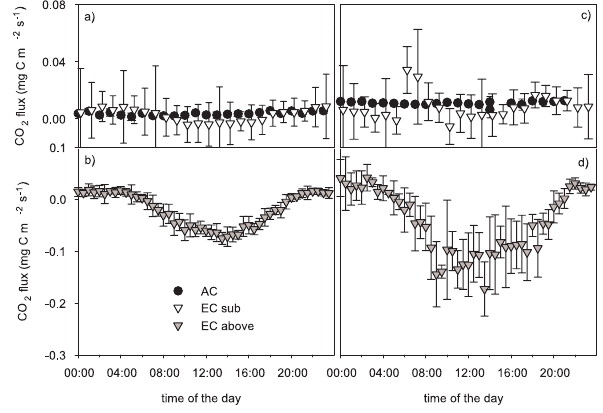
Fig. 4. Daily time course of CO 2 fluxes at the drained peat- land pine forest measured with automatic chambers (AC) and sub- canopy eddy covariance (EC sub) (a), (c) and above canopy eddy covariance (EC above) (b), (d) during a cold period in 30 April– 10 May 2007 (a), (b) and a warm period in 5–15 June 2007 (c), (d). Dots represent median values for each hour (AC, EC sub) or half hour (EC above) over the 10-day period. Error bars represent standard